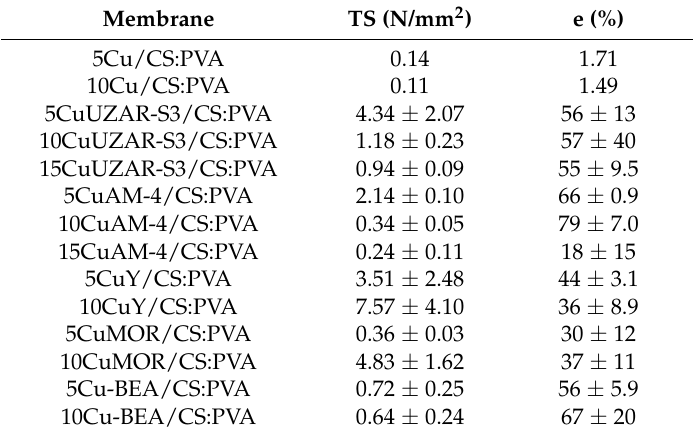
Table 3. Tensile strength and elongation at break of the wet Cu-filled CS:PVA membranes. Membrane TS (N/mm 2 ) e (%) 5Cu/CS:PVA 0.14 1.71 10Cu/CS:PVA